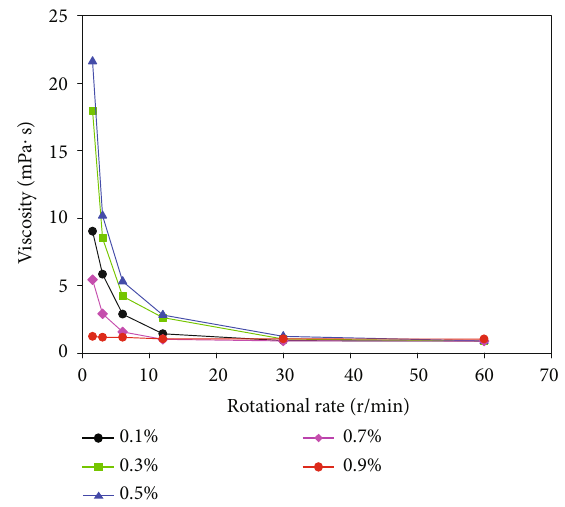
Figure 6: Shear thinning of nanosilica particle aqueous dispersion.